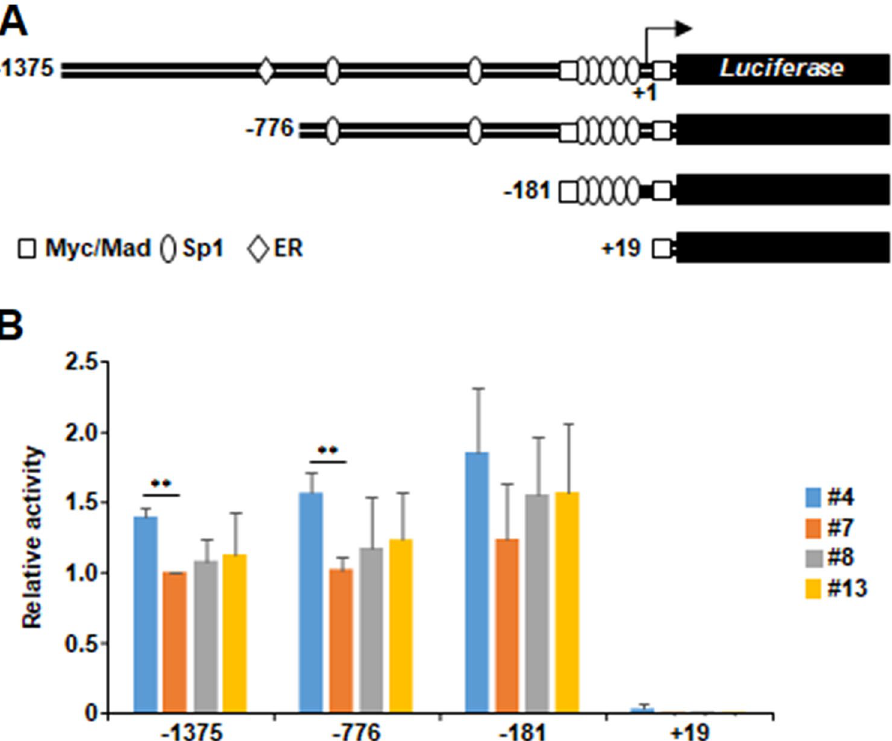
Figure 3. Transcription from transiently transfected pTERT-Luc reporter plasmids could not reconstitute the downregulation of endogenous TERT transcription by TAF-I KD. ( A ) Schematic diagrams of pTERT-Luc reporter genes. The upstream and downstream nucleotide positions from transcription start site (+ 1) of each pTERT-Luc plasmid are shown. Binding sites for major transcription factors such as Myc/Mad, Sp1, and ER are represented. ( B ) Results of luciferase assay. Each pTERT-Luc reporter plasmid together with pEF1α-RLuc control plasmid were transfected into WT and TAF-I KD cells. Renilla luciferase was used as an internal control. After 48 h post transfection, cells were collected, and cell extract was prepared and subjected to measure both firefly and renilla luciferase activities. Each value of firefly luciferase activity was normalized by dividing it with that of renilla luciferase. Each relative value when the normalized value of pTERT-1375-Luc-transfected clone #7 cells was set to be 1.0 was represented. Values represent the mean ± SD (n = 3). ** P < 0.01 relative to